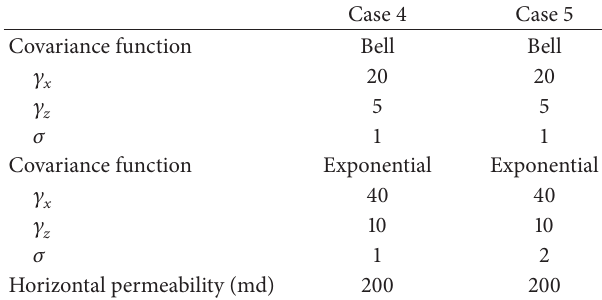
Table 3: Variables for multiscale